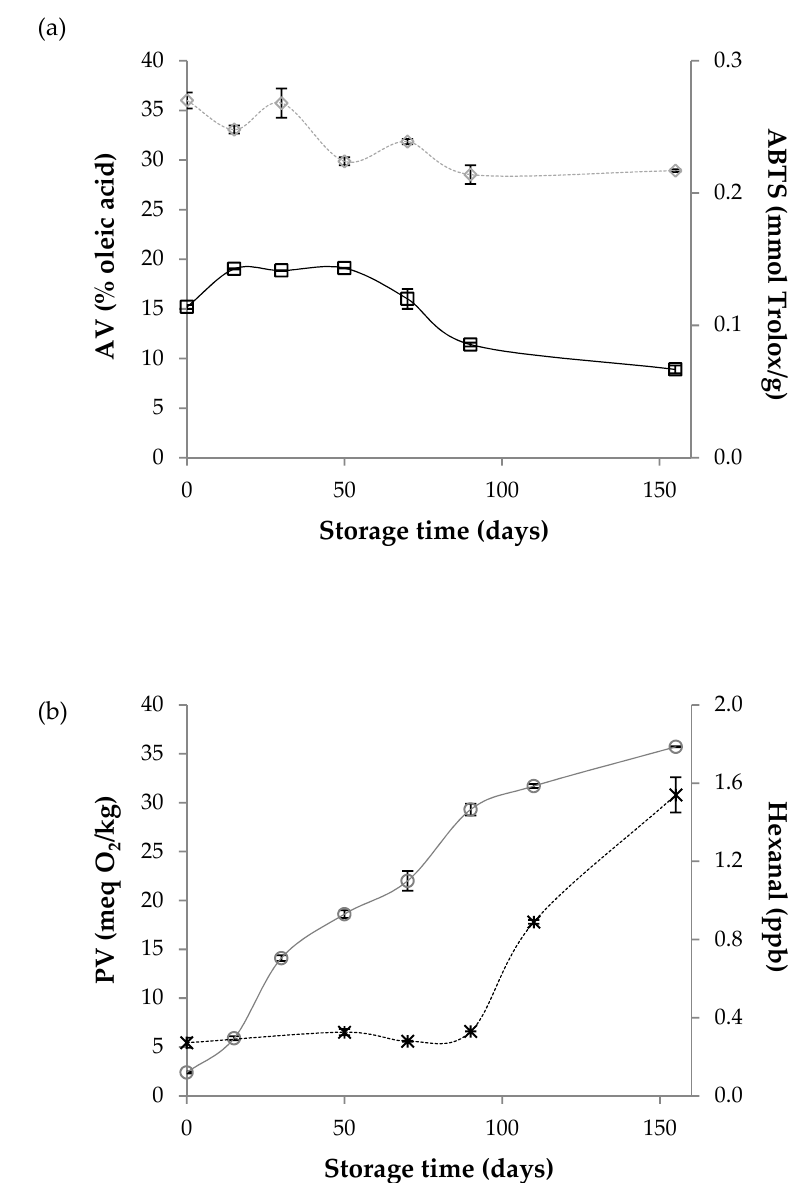
Figure 3. Evolution of: ( a ) acidity value (AV) and antioxidant activity (ABTS values) and ( b ) peroxide value (PV) and hexanal content, of the SCWBOE, measured during a storage period of 155 days at 21 ± 1 °C and in darkness.